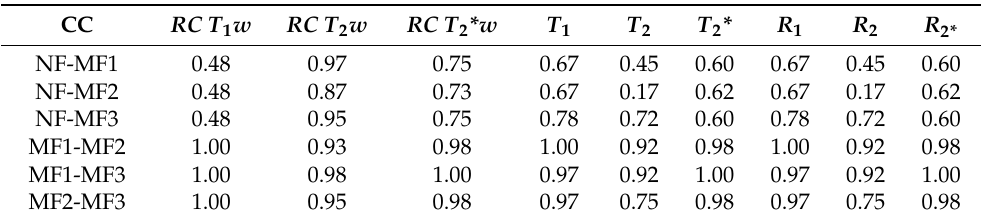
Table 2. Calculated Spearman correlation coefficients (CC) between the different LFs of NF and MF cores for all defined MRI parameters ( RC , T , R